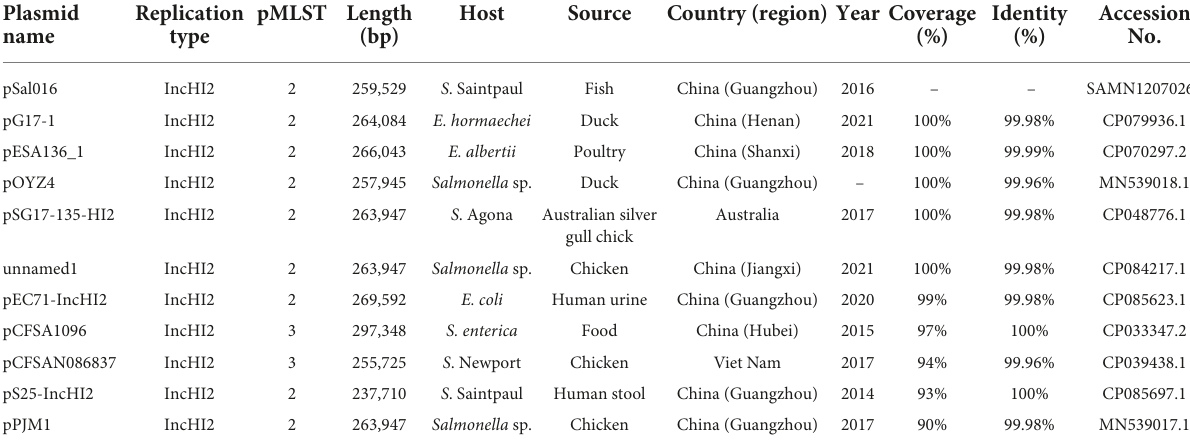
TABLE 2 Characteristics of plasmids highly similar to pSal016.